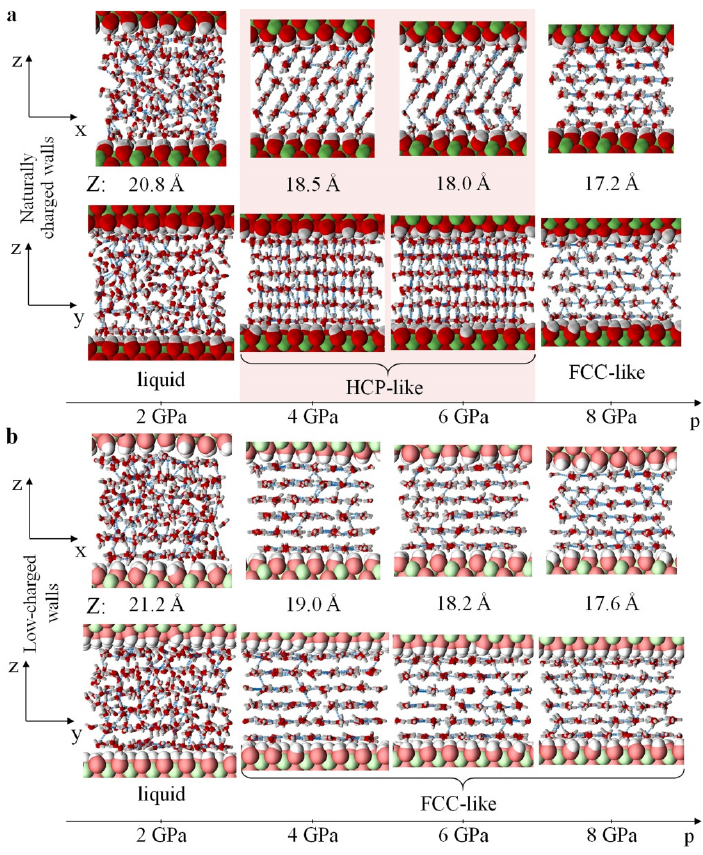
Figure 3. Structure of nanoconfined water depending on pressure and wall surface polarity: Representative views of nanoconfined water in the naturally charged ( a ) and low-charged ( b ) host models in the considered pressure range. Color code: Me (II) —green, O—red, H—white, hydrogen bonds—light blue; pale colors of wall atoms indicate 10-fold-reduced partial atomic charges. The results are for the base models of 36[2Me (II) (OH) 2 ·7H 2 O].